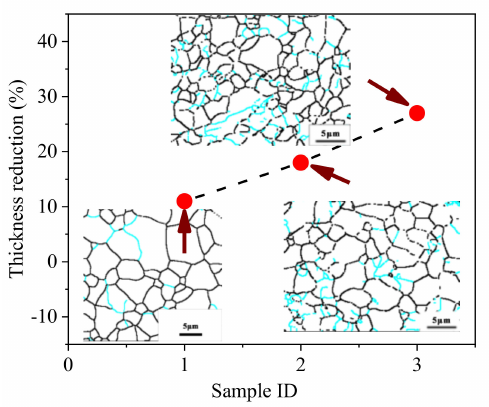
Figure 3. Distribution map of backscattered diffraction grain boundary of high-strength steel matrix at different reduction rates and cooling rates after hot rolling. The low-angle grain boundaries (2–15 ◦ ) are in black and high angle boundaries (>15 ◦ ) are shown in blue based on the misorientation